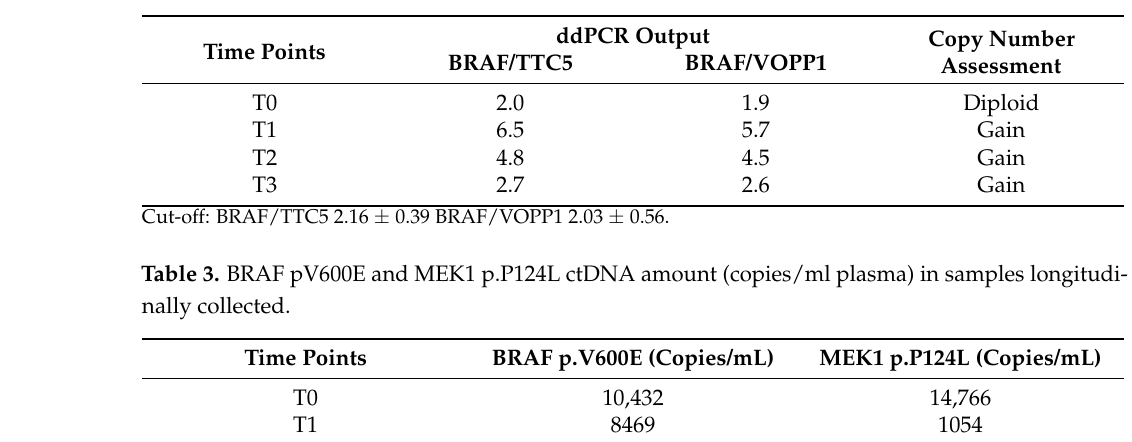
Table 2. Summary of BRAF CNV analysis longitudinally monitored.